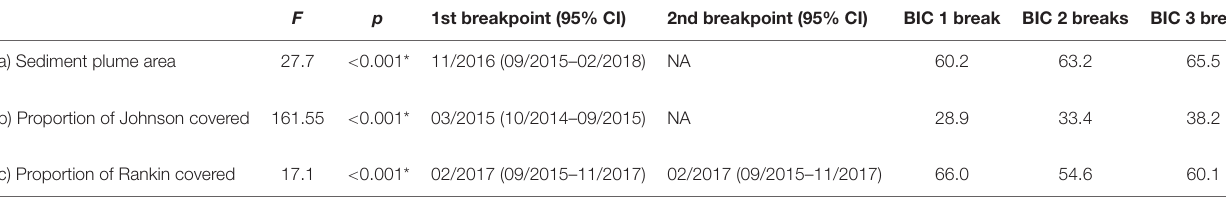
TABLE 3 | Breakpoint analysis used to determine significant changes in sediment plume